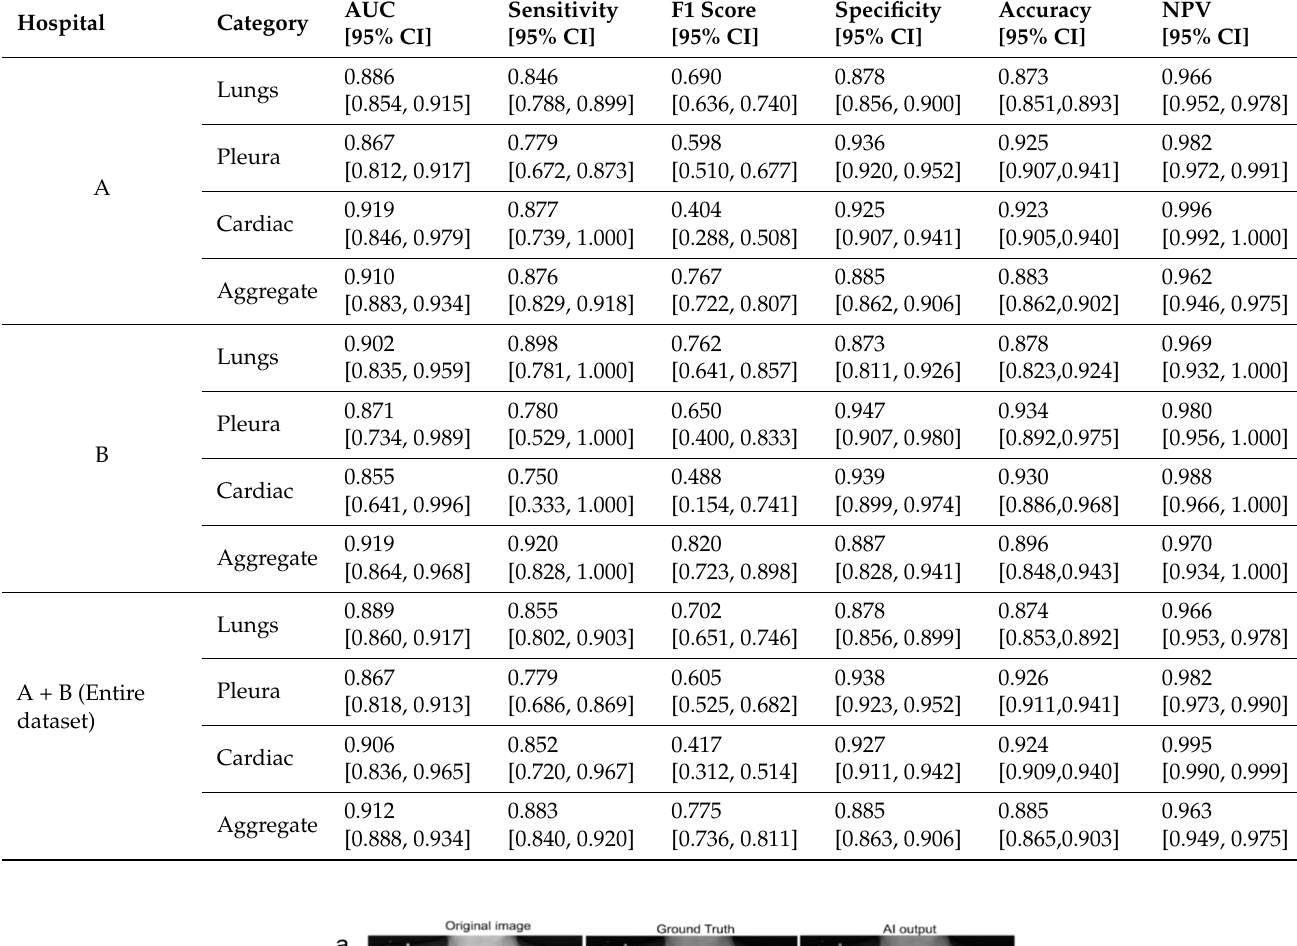
Table 3. Performance of the standalone AI model on 2 external validation datasets.